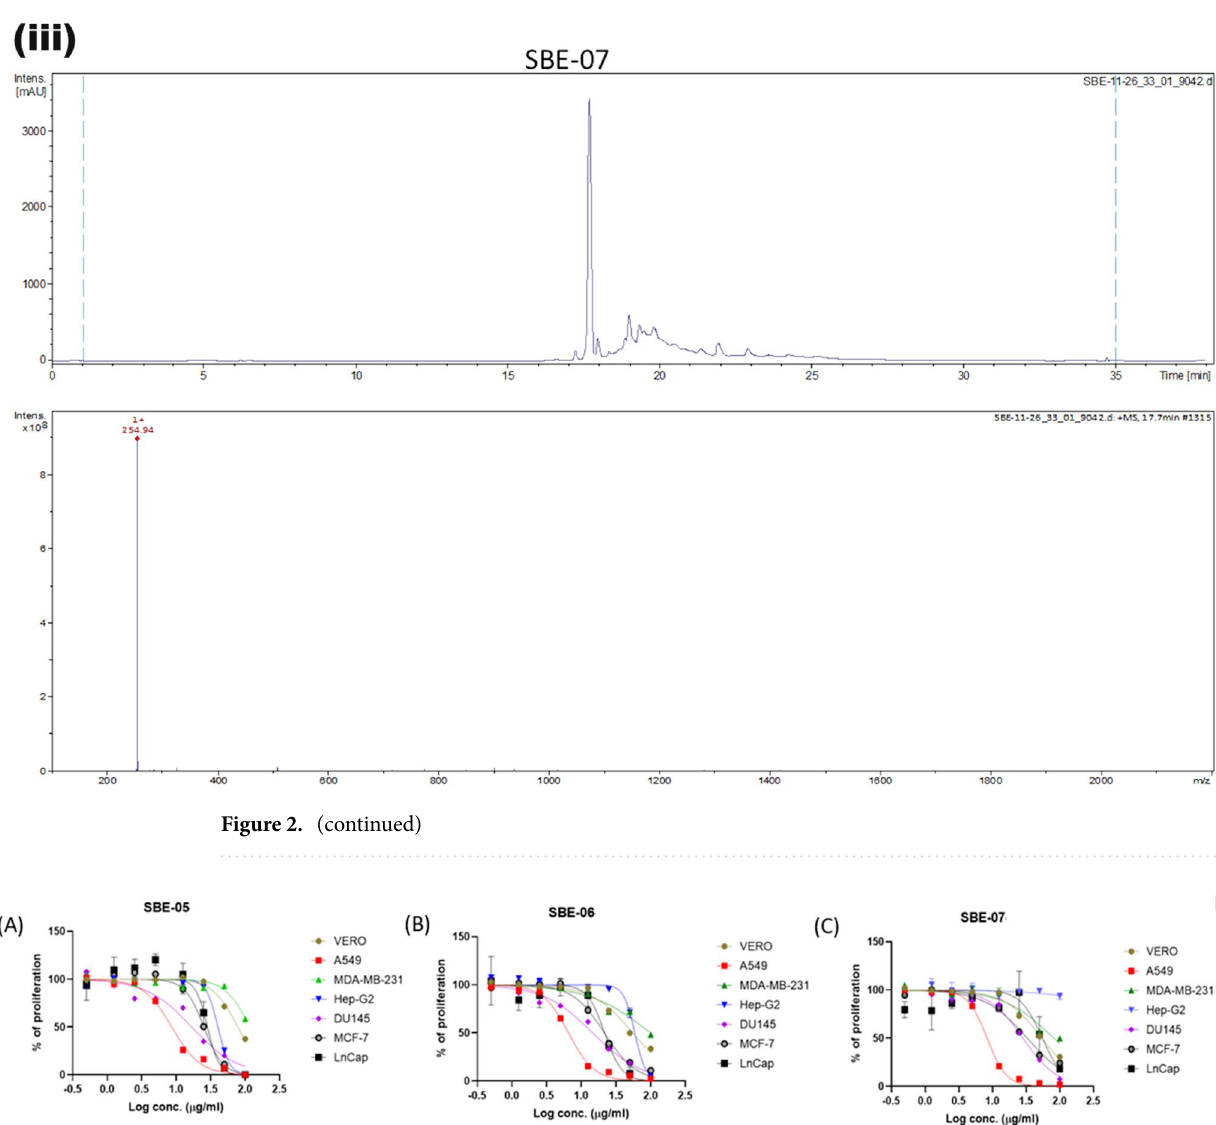
Figure 3. ( A – C ): Cytotoxic potential of SBE-05, SBE-06 and SBE-07 against A549, MCF-7, MDA-MB-231, Hep-G2, LnCaP, DU145 and VERO